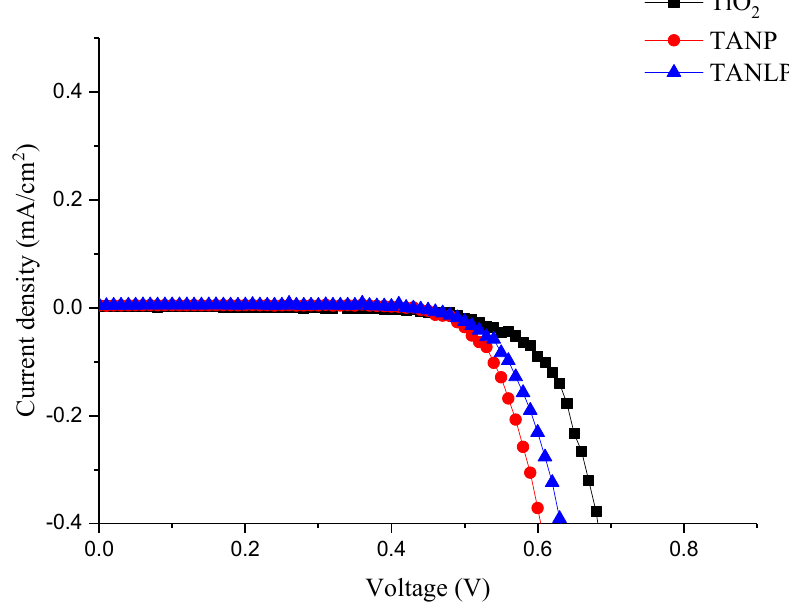
Figure 6. The I-V characteristics of TiO 2 , TANP, and TANLP in dark conditions.